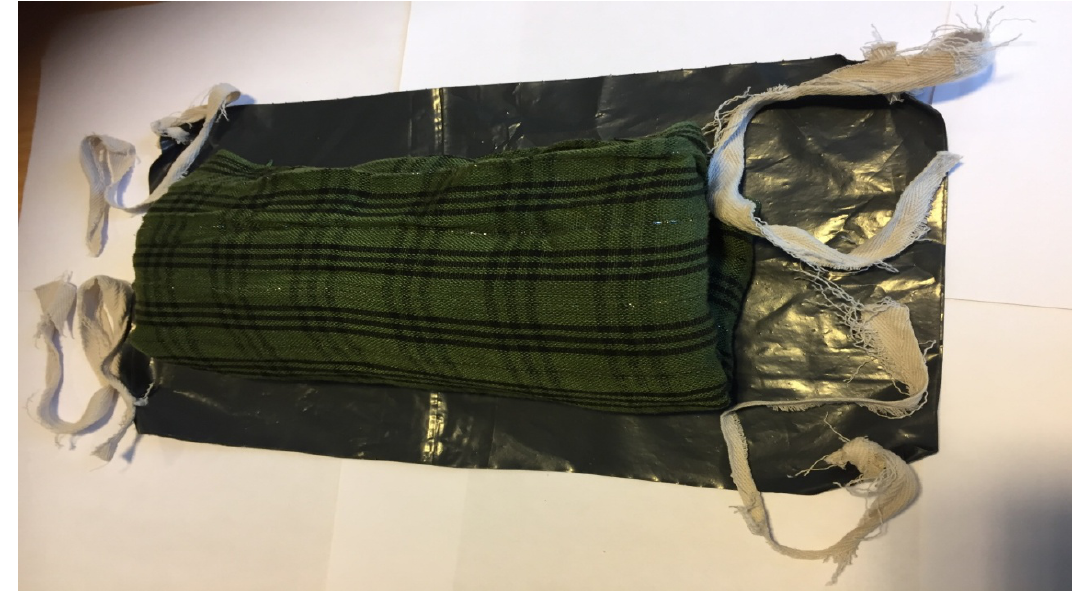
Figure 2. Showing a folded cloth pad on a water proof black plastic sheet. Picture taken with patient’s consent.